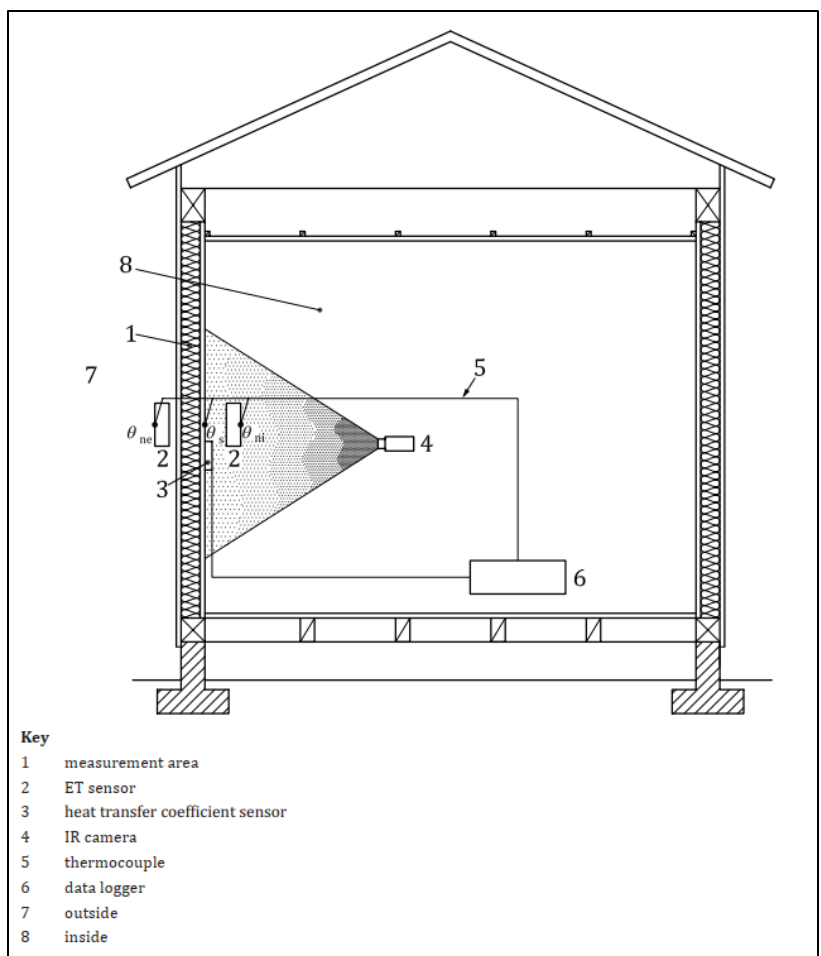
Figure 23. IRT Measurement